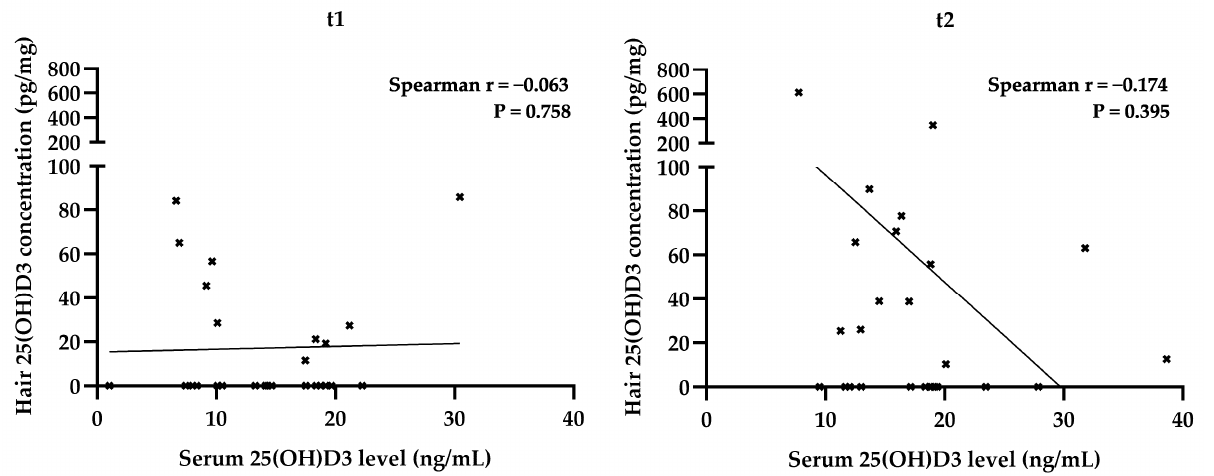
Figure 2. Correlation of hair and serum 25(OH)D3 levels of 26 healthy Caucasian adult subjects whose blood and hair were sampled at 2 different timepoints t1 and t2. The values of Spearman’s correlation coefficients show that there is no relationship between the variables.